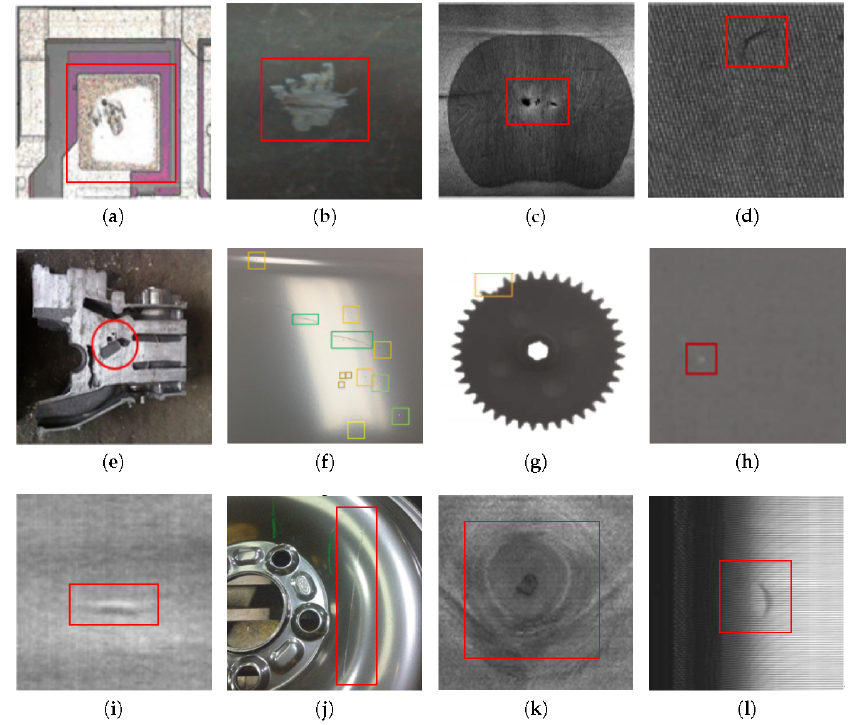
Figure 1. Defects in different areas: ( a ) metallization peeloff of electronic components [18]. ( b ) pipeline corrosion [19]. ( c ) defective with gas pore [20]. ( d ) defect bigknot of textile materials [21]. ( e ) shrinkage and porosity defect of Casting [22]. ( f ) defects in green, yellow, orange bounding box are scratch, cratering, hump, respectively in carbody [23]. ( g ) Lack defect of gear [24]. ( h ) light leakage defect on mobile screen [25]. ( i ) Convexity defect in aluminum foil [26]. ( j ) Scratch defect of the wheel hub [27]. ( k ) Branch defect of wood veneer [28]. ( l ) Bubble defect of tire sidewall